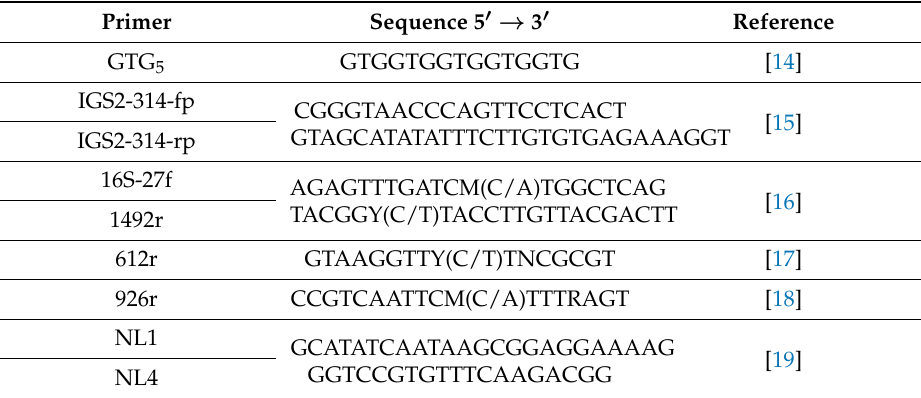
Table 1. Primers used in this